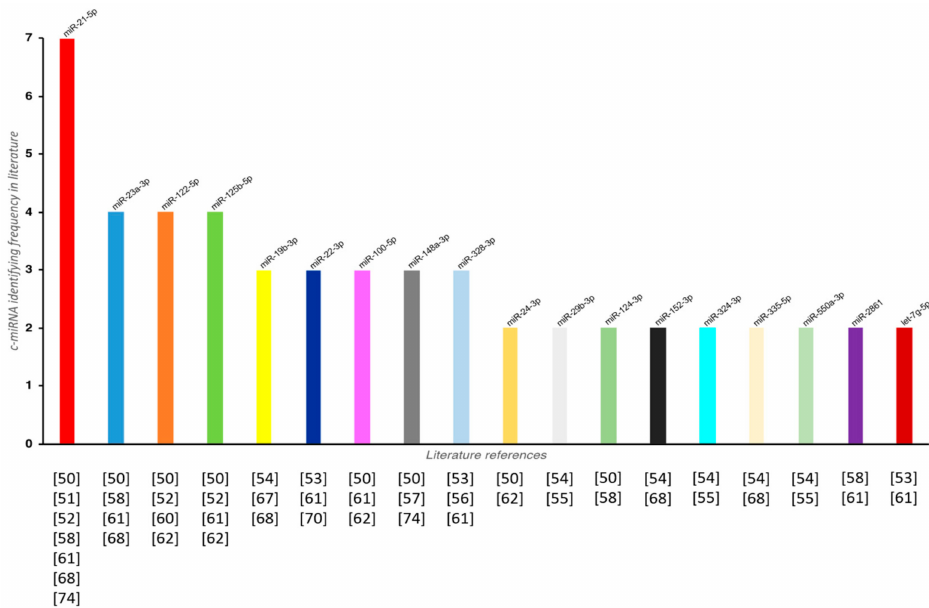
Figure 2. c-miRNAs literature distribution. The figure shows the most important c-miRNAs that have been suggested as potential novel biomarkers for bone fragility. These molecules are seeded based on their identifying frequency in the literature to date. Those with frequency = 1 are not